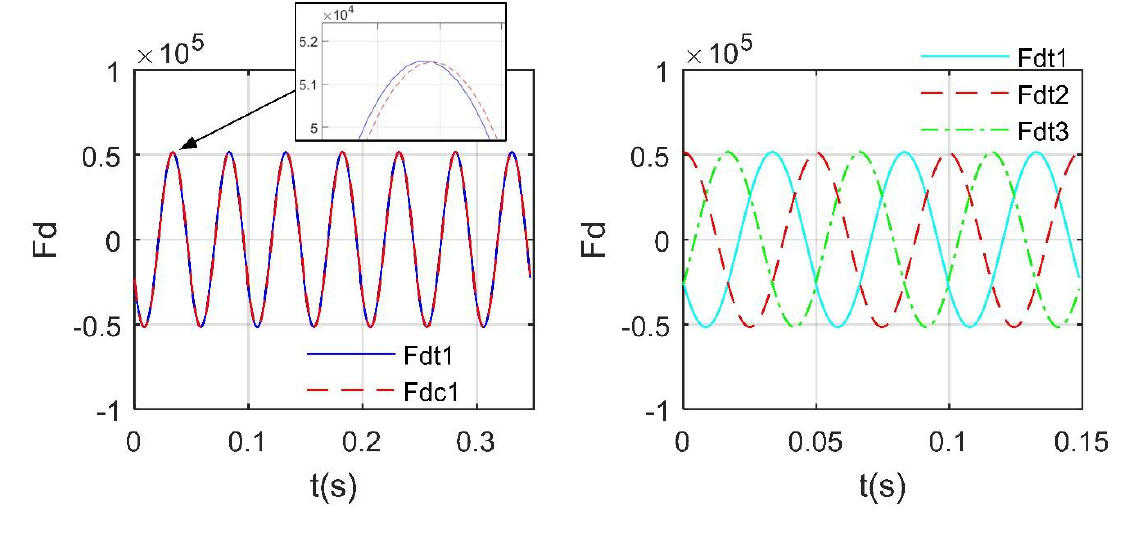
( a ) Doppler characteristic difference. ( b ) Doppler characteristics at the blade tip. Figure 17. Doppler feature of the rotor 1, α = 27°, β = 0°, A df = A dr = 0°, f RH = 10 GHz, V m = 0 m/s, n r1 = 1200 r/min.